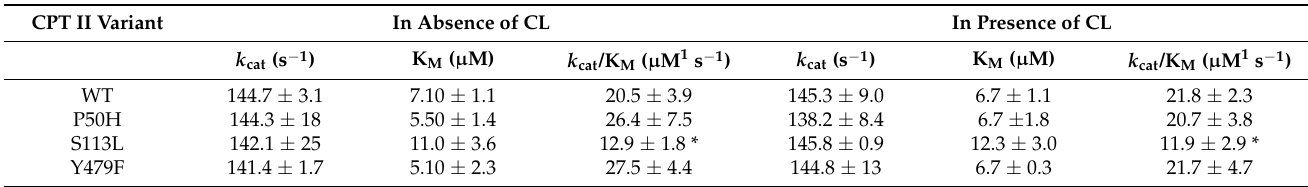
Table 1. Effect of 0.25 mM CL on the kinetic parameters k cat and K M and the catalytic efficiency of CPT II WT and variants for palmitoyl-CoA as varying substrate at 25 ◦ C ( n ≥ 3).